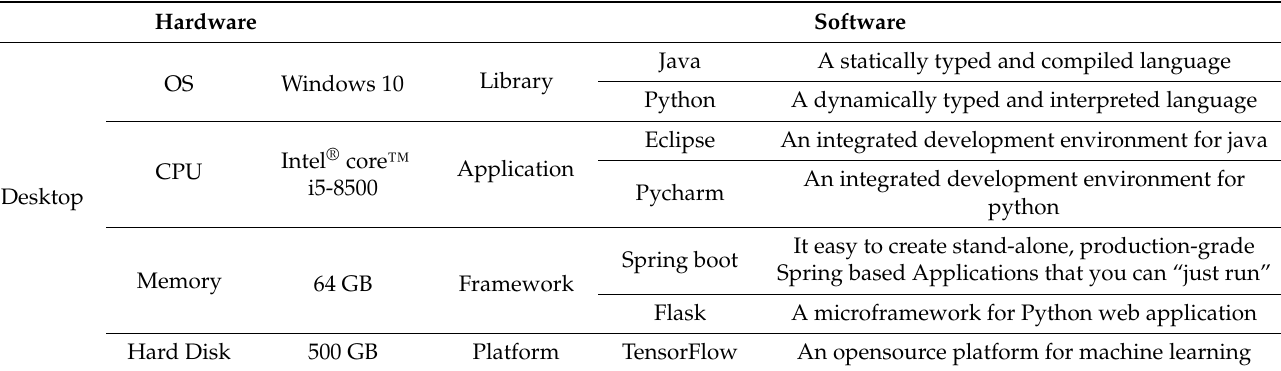
Table 2. Specifications of Development Environment for Environment Optimization Scheme based on Edge Computing Platform.